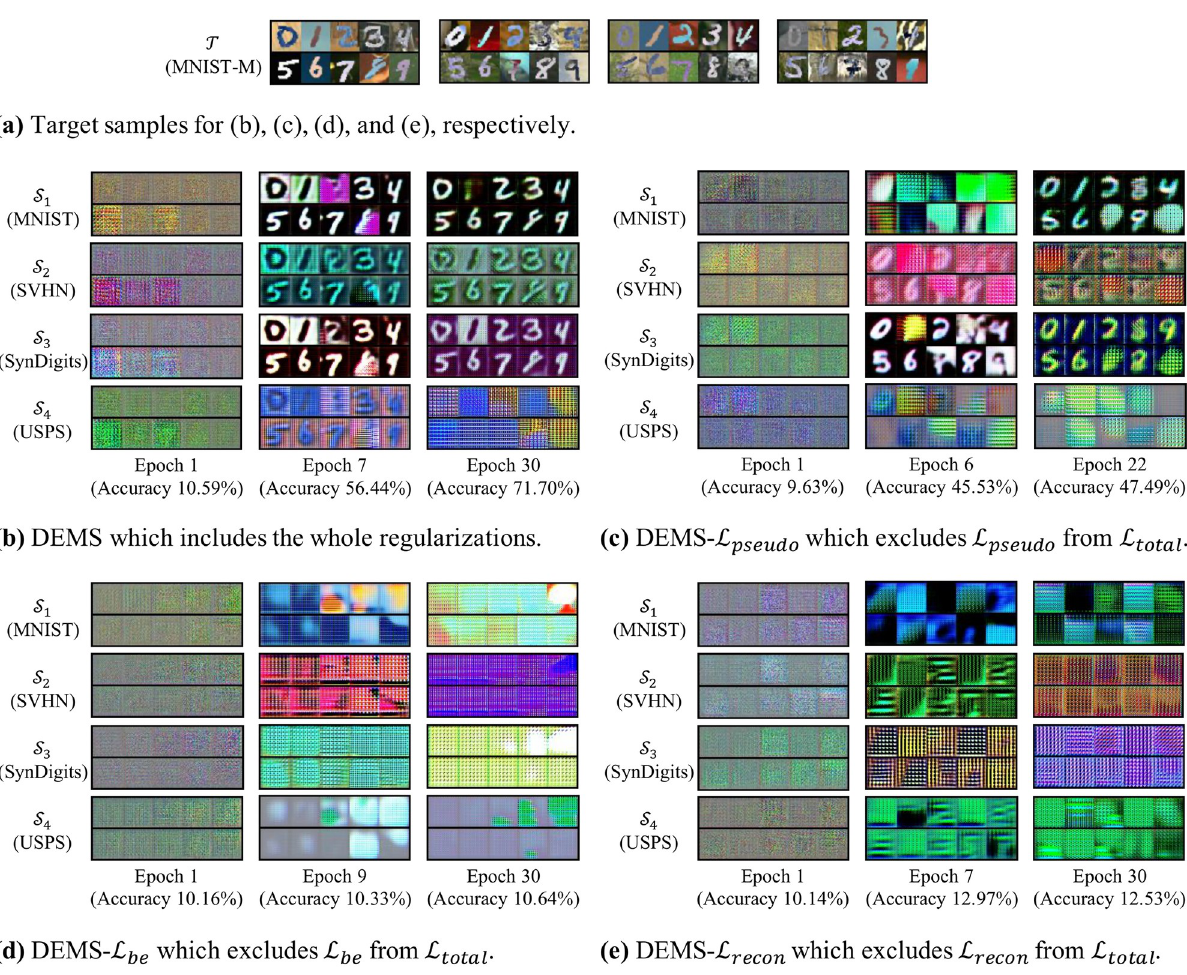
Fig 5. Visualization of image adaptation from MNIST-M to other source domains. Fig (a) enumerates target samples for Figs (b), (c), (d), and (e). The target samples are adapted by adaptation networks which are trained with different losses. For DEMS (Fig (b)), the adaptation gradually focuses on the close source domains (MNIST, SVHN, and SynDigits), resulting in performance enhancement. For DEMS (cid:0) L 7, and 9) are failed to be adapted to source domains. For DEMS (cid:0) L